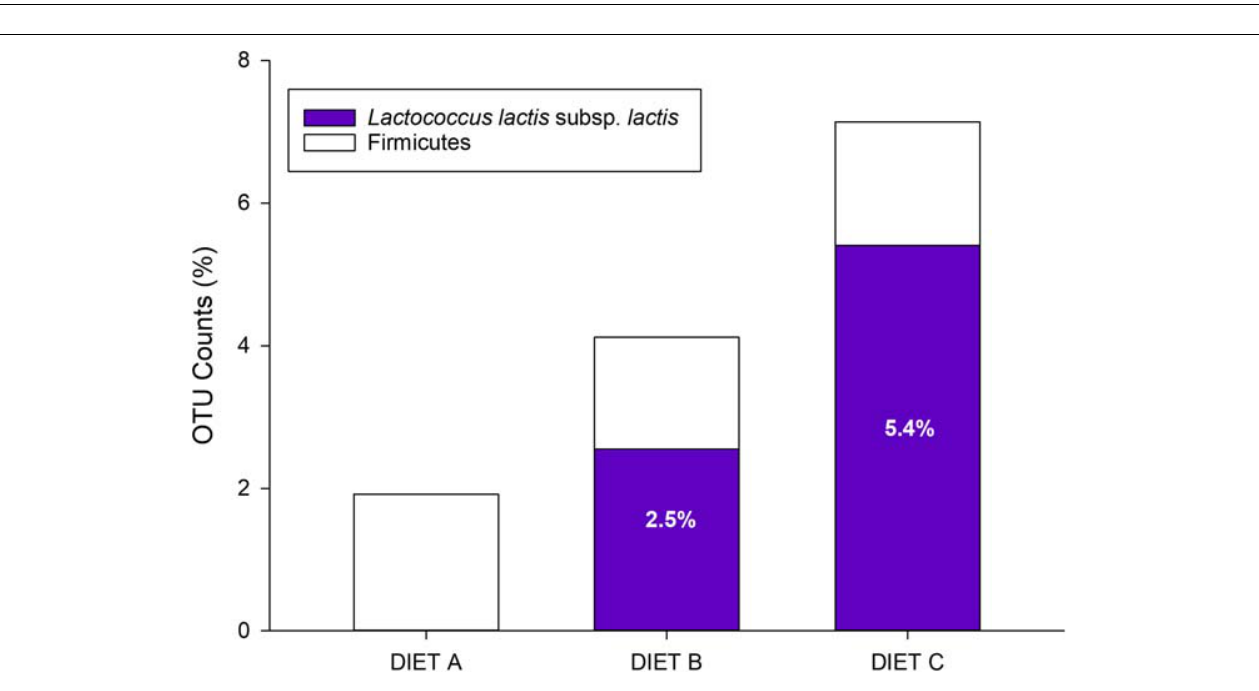
FIGURE 3 | Relative abundance of Firmicutes phylum and Lactococcus lactis subsp. lactis in control (Diet A) and experimental diets (Diets B and C).